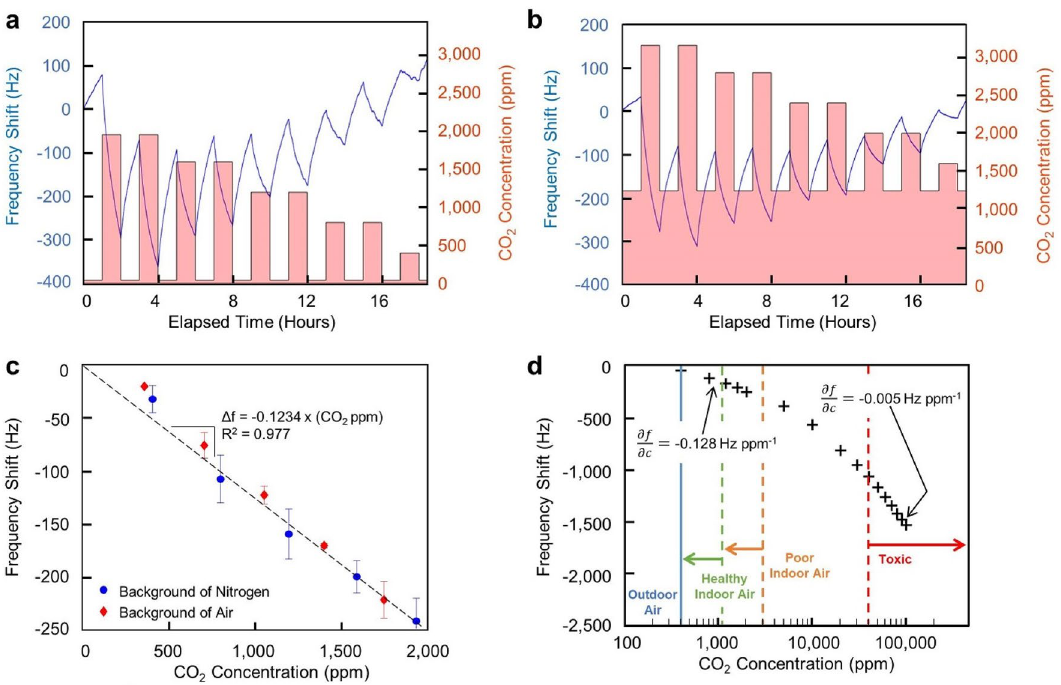
Figure 1. Sensor response to CO 2 shown as a frequency shift of the resonant element. ( a ) Sensor response to CO 2 over time with a background of nitrogen. The resonant frequency shift response is indicated by the blue line (left vertical axis), and the red bars indicate when CO 2 is present (right vertical axis). ( b ) Sensor response to CO 2 over time with a background of air. The resonant frequency shift response is indicated by the blue line (left vertical axis), and the red bars indicate when CO 2 is present (right vertical axis). The use of air brought the baseline CO 2 concentration to 1200 ppm. ( c ) Total frequency shift of the device after 1 h of CO 2 at specified concentrations. The average of 8 responses is shown with error bars representing one standard deviation. Regardless of the baseline conditions, a similar linear response is obtained by the sensor, as demonstrated by the linear regression fit. ( d ) The dynamic range of the sensor is shown by plotting the resonant frequency shift in response to 1 h of CO 2 in a background of nitrogen. For comparison, outdoor air CO 2 concentrations 35 are indicated by the solid blue line, healthy indoor air CO 2 levels 32 are indicated by the dashed green line, poor indoor air CO 2 levels 32,36 are indicated by the dashed orange line, and toxic CO 2 levels 37 are indicated by the dashed red line. Additionally, the sensitivity (indicated by the change in frequency per change in CO 2 ∂ f concentration, ∂ c ) is shown at both low and high